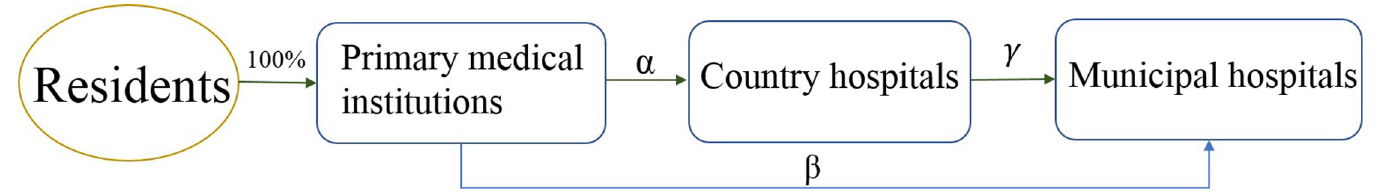
Fig 2. Residents’ treatment process under the hierarchical diagnosis and treatment